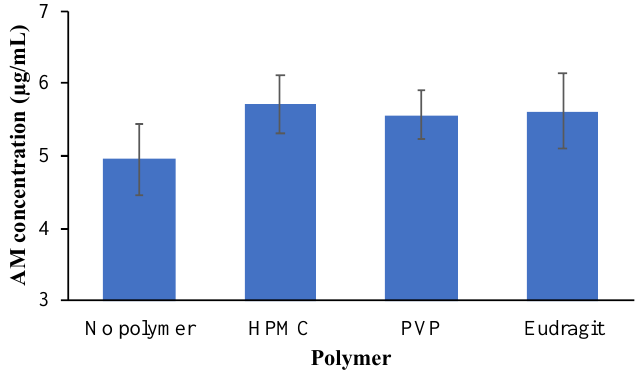
Figure 4. Crystalline Solubility of AM at 25 °C in each polymer solution at the concentration of 500 μg/mL .